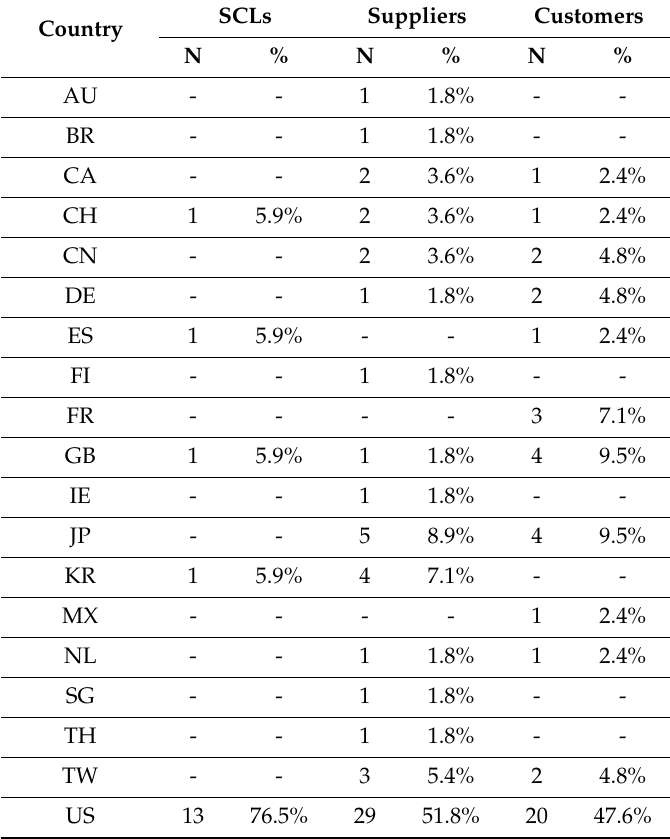
Table A4. Distribution of central sample firms per country.